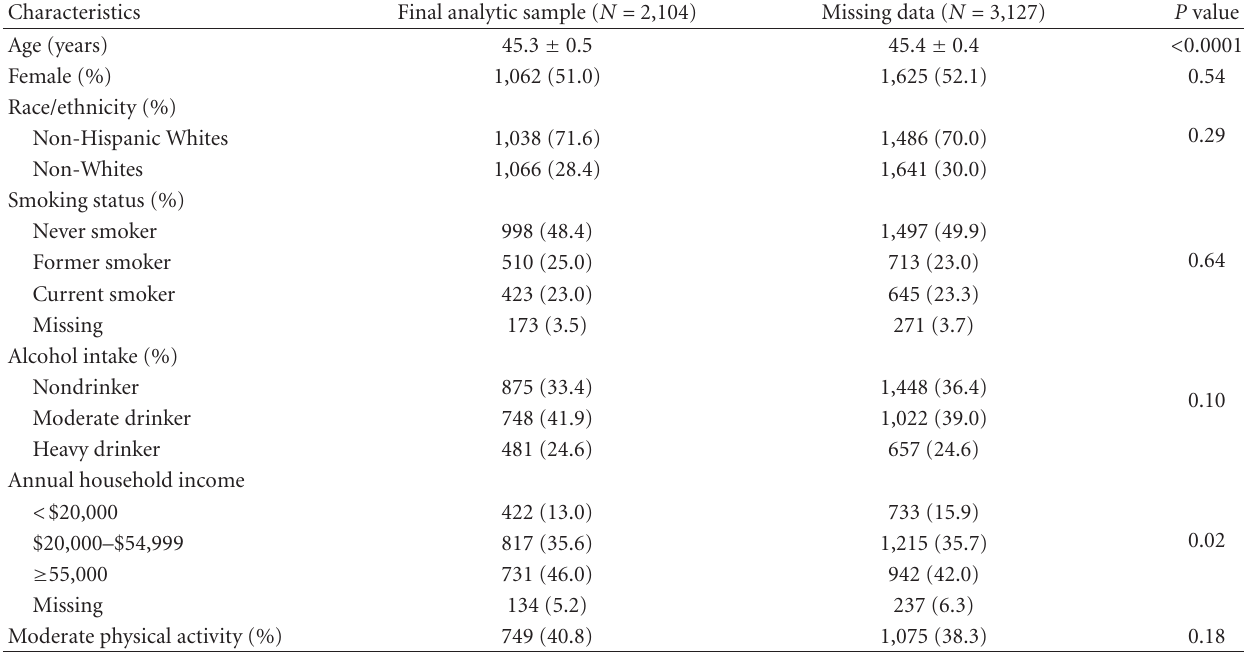
Table 3: Comparison of those who were included the final analytic sample to those who were excluded due to missing data a .